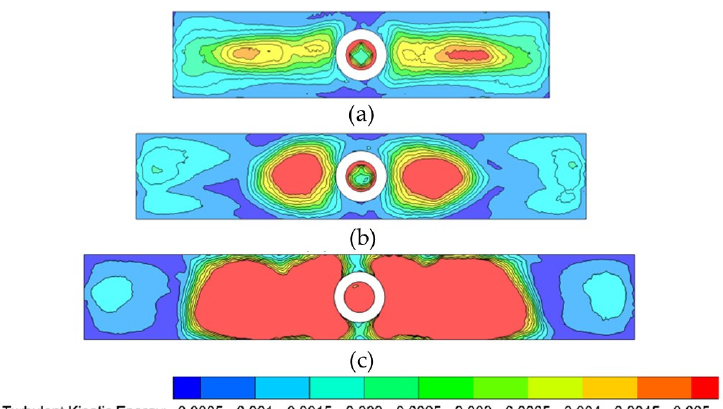
Figure 6. Contour of turbulent kinetic energy on the free surface of the mold with different widths under low steel throughput: ( a ) 880 mm, ( b ) 1050 mm, and ( c ) 1300 mm.